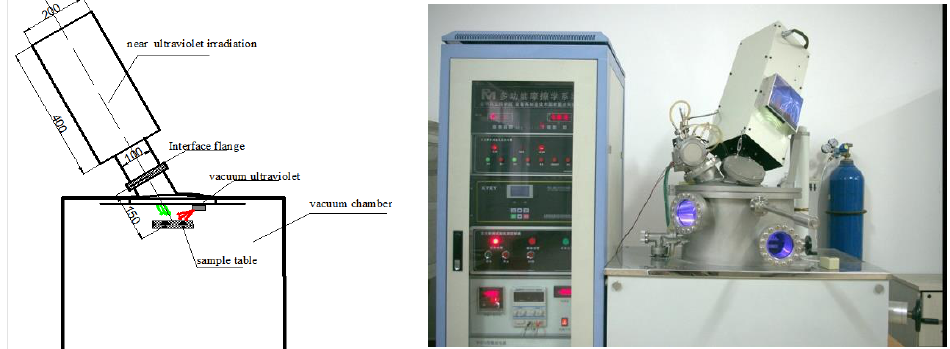
Figure 1. The schematic diagram of the UV radiation simulation device and MSTS-1 vacuum friction and wear tester integrated with UV radiation simulation device. Table 1. Technical parameters of space UV radiation simulation